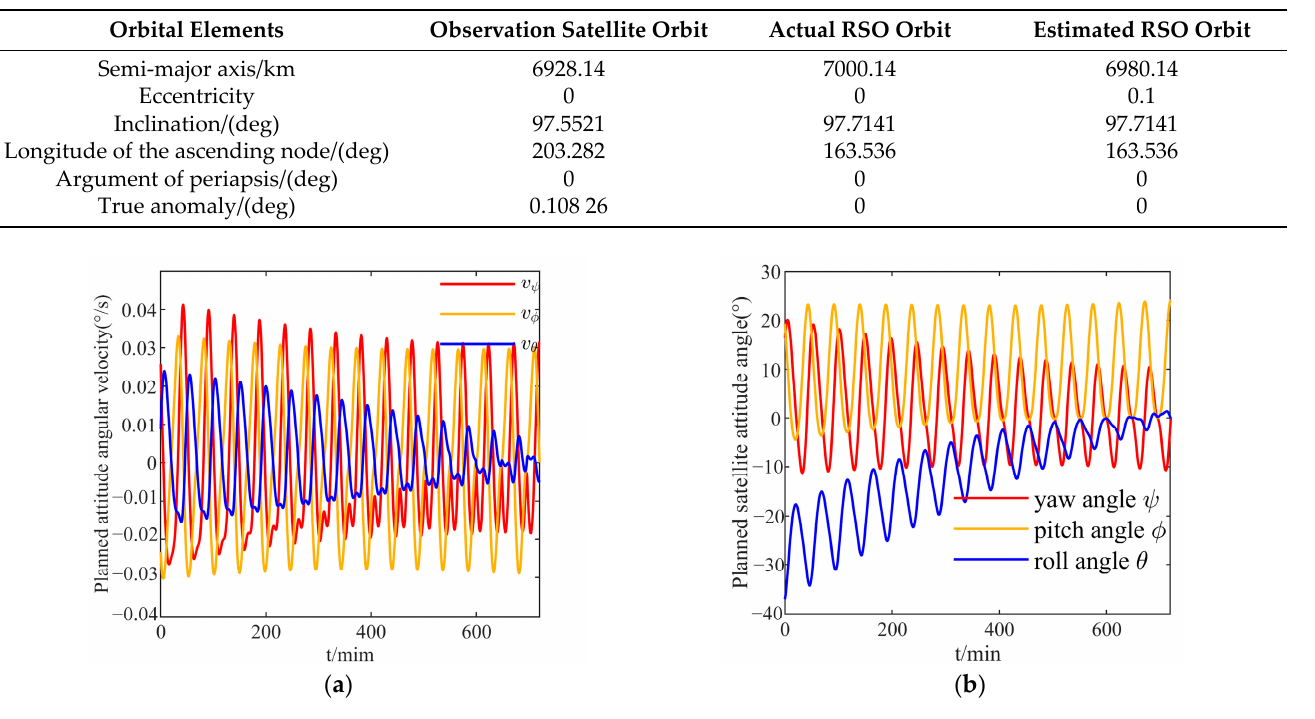
Table 2. Orbital elements of the observation satellite and the RSO.